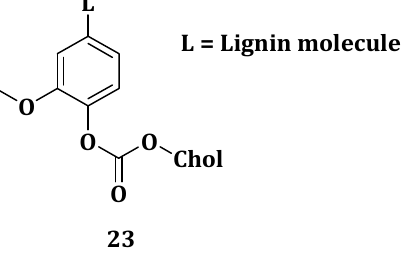
Figure 11. Structure of ASKL-Chol ( 23 ).